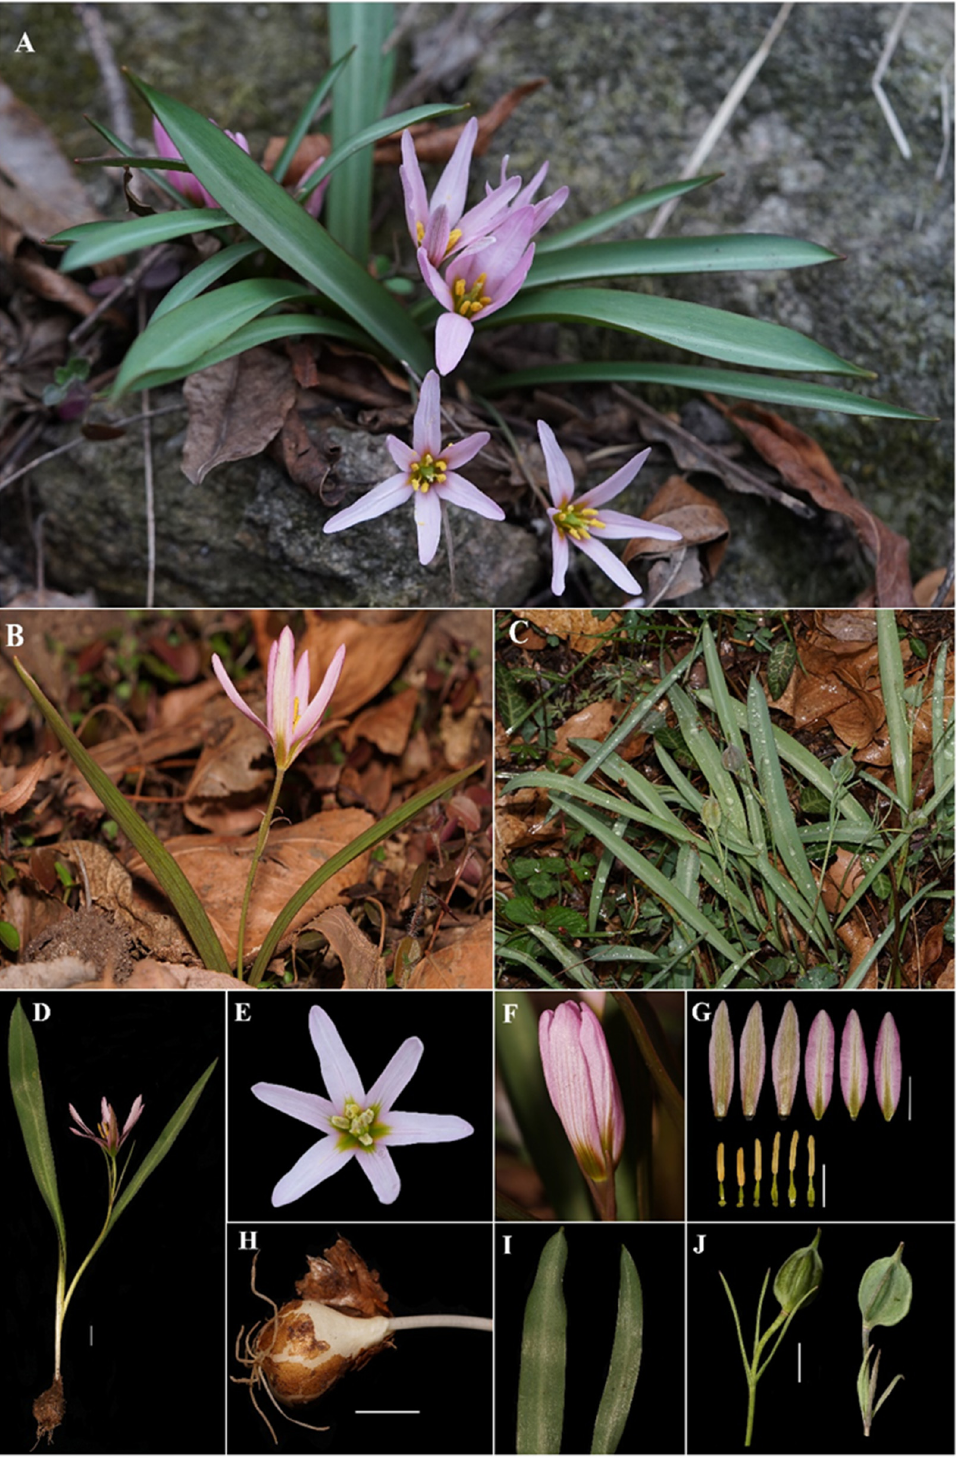
Figure 2. ( A – J ) Amana hejiaqingii : ( A ) Habitat, ( B ) Individual, ( C ) Population with fruits, ( D ) Whole plant, ( E ) The front view of the flower, ( F ) The side view of the flower, ( G ) Anatomy of flower, ( H ) Bulb, ( I ) Leaves, ( J ) Fruits. The white line segment represents a length of 1 cm.